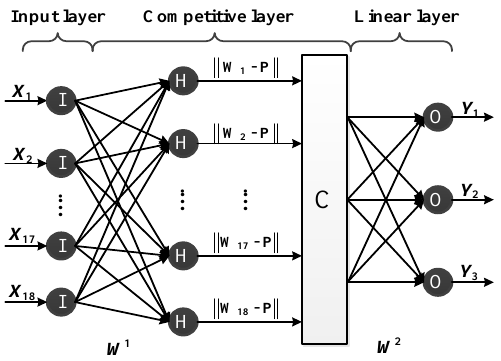
Figure 8. Architecture of learning vector quantization (LVQ) neural network.